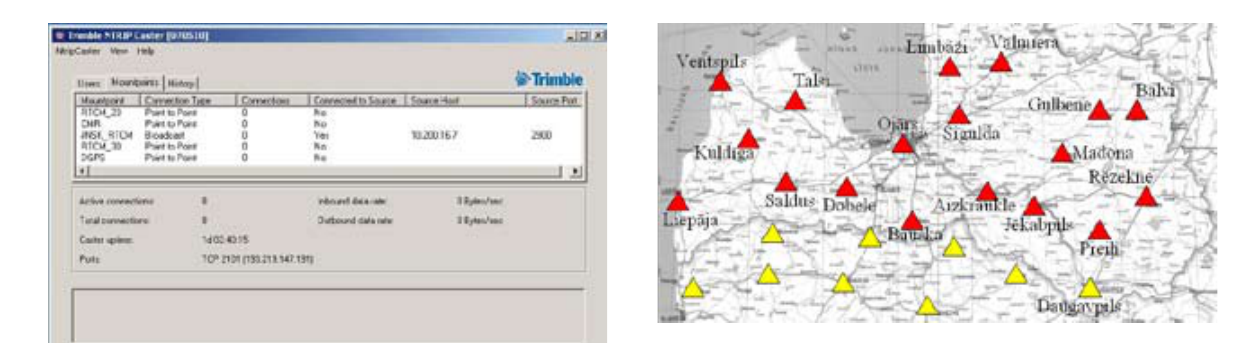
Fig. 10 . Information on RINEX